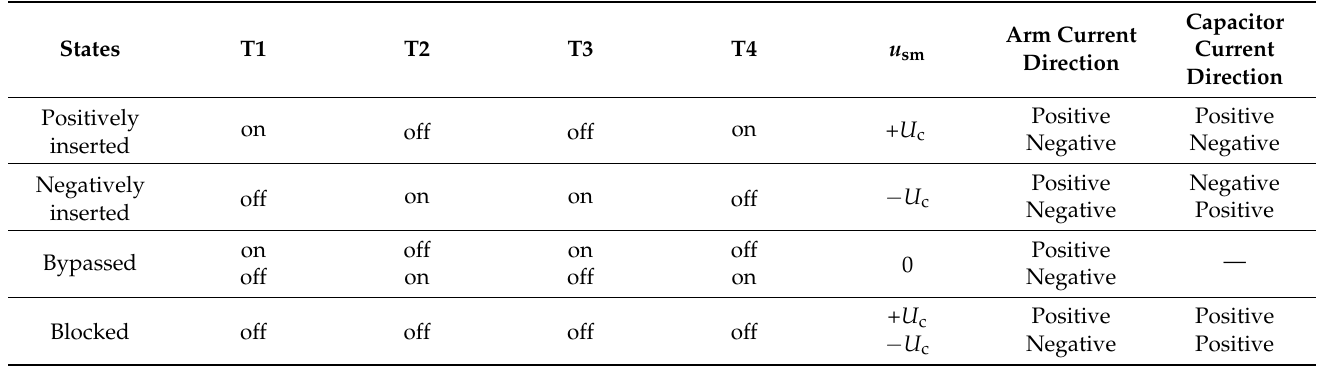
Table 1. Operating states of